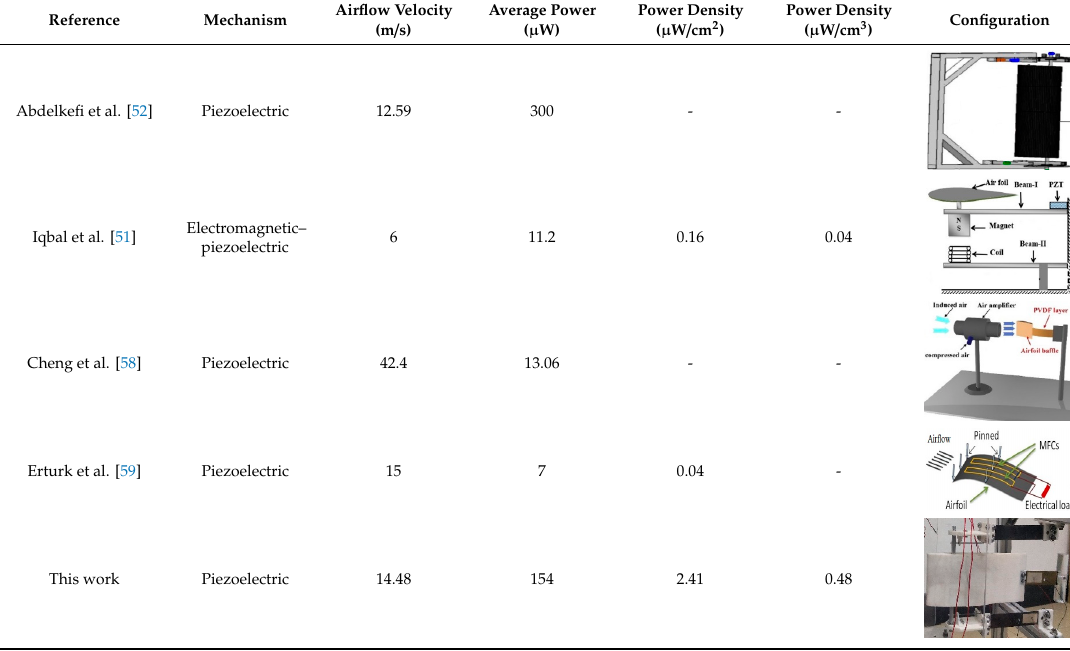
Table 4. The compared harvesters adopt the piezoelectric and electromagnetic–piezoelectric mechanisms, but they are all subjected to the incoming airflow. It should be noted that the power densities are defined as P ave / A m and P ave /V m , where P ave represents the average output power of the harvester; A m denotes the maximum side area of the entire harvester; and V m is the maximum volume of the harvester. The power densities of the proposed harvesters are 2.41 and 0.48 μ W/cm 3 , respectively, which demonstrates the superior harvesting performance over the other ones. Table 4. Comparison of output performance between the previous and proposed harvesters.